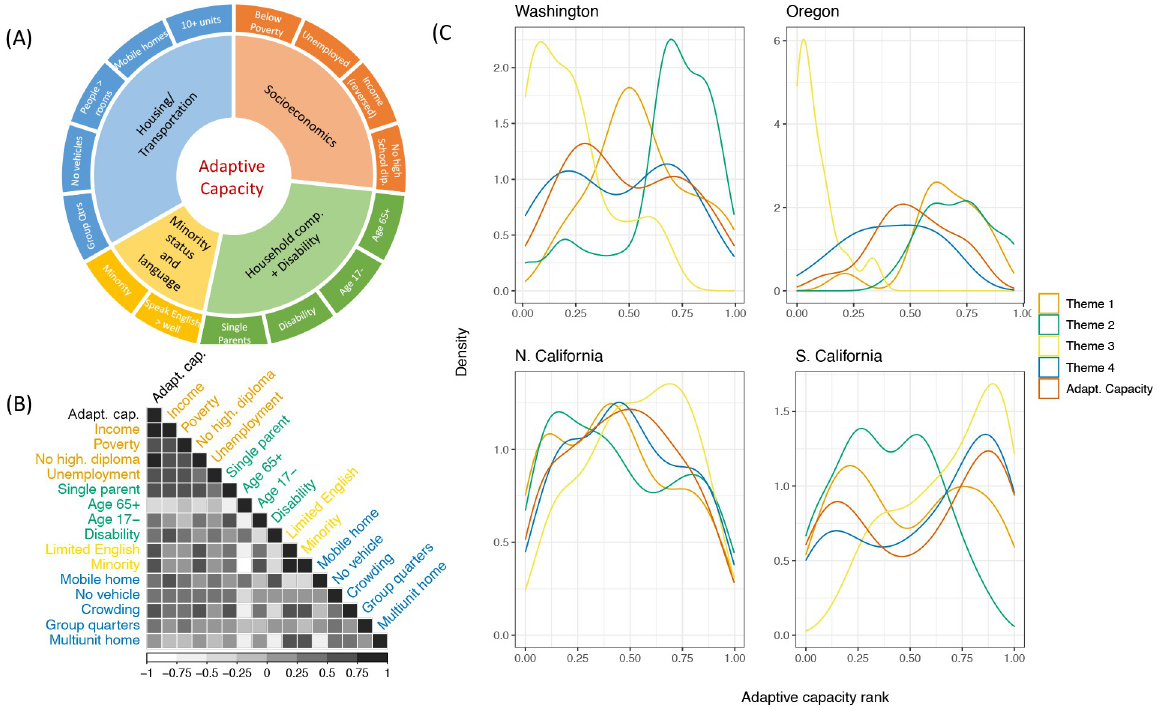
Fig 4. Social indicators and themes that make up adaptive capacity and relation to final adaptive capacity scores. (A) the four themes of adaptive capacity and individual indicators that make up each. Theme 1 is socioeconomic indicators (orange), theme 2 (green) is household composition and disability, theme 3 (yellow) is minority status and language, and theme 4 (blue) is housing/transportation. (B) The correlation between adaptive capacity and each individual indicator colored by theme. (C) The density distribution of scores for each theme and overall adaptive capacity (where greater values = lower adaptive capacity) for each geographic